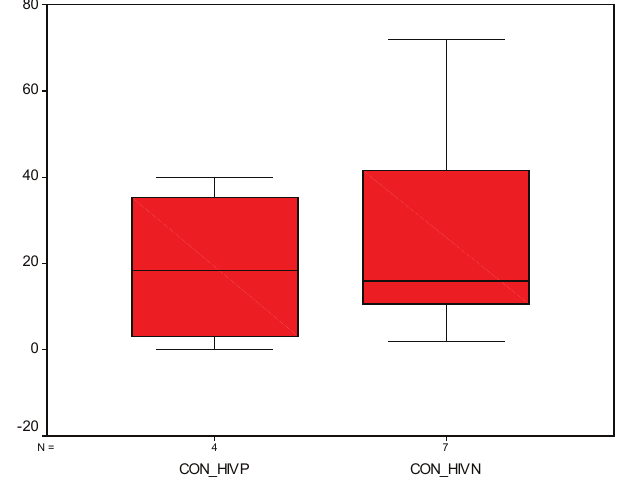
FIGURE 4 – Boxplot – Comparison of Langerhans cell populations between HIV-positive and negative controls.